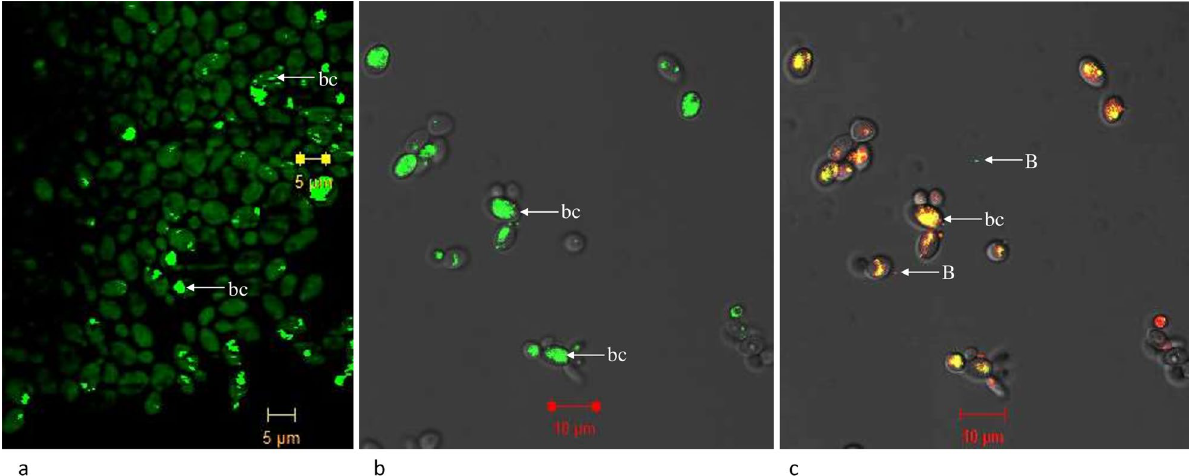
Figure 6. Confocal fluorescence microscopic FISH images of Candida tropicalis. ( a ) Native bacterial community (bc) of the yeast showing the green fluorescence inside the yeast cells ( b ) Infection studies showing native bacterial community (bc) of the yeast showing green fluorescent while the mCherry tagged P. stutzeri have red fluorescent and an over lay of the image ( c ) shows the presence of both native community along with the infected cells inside the yeast cells. Bacterial communities associated with the yeast cells were stained with rRNA bacterial EUB338-Cy3 probe (green). Arrows indicate: bc, bacterial communities; B, Bacterial cells which are seen outside the